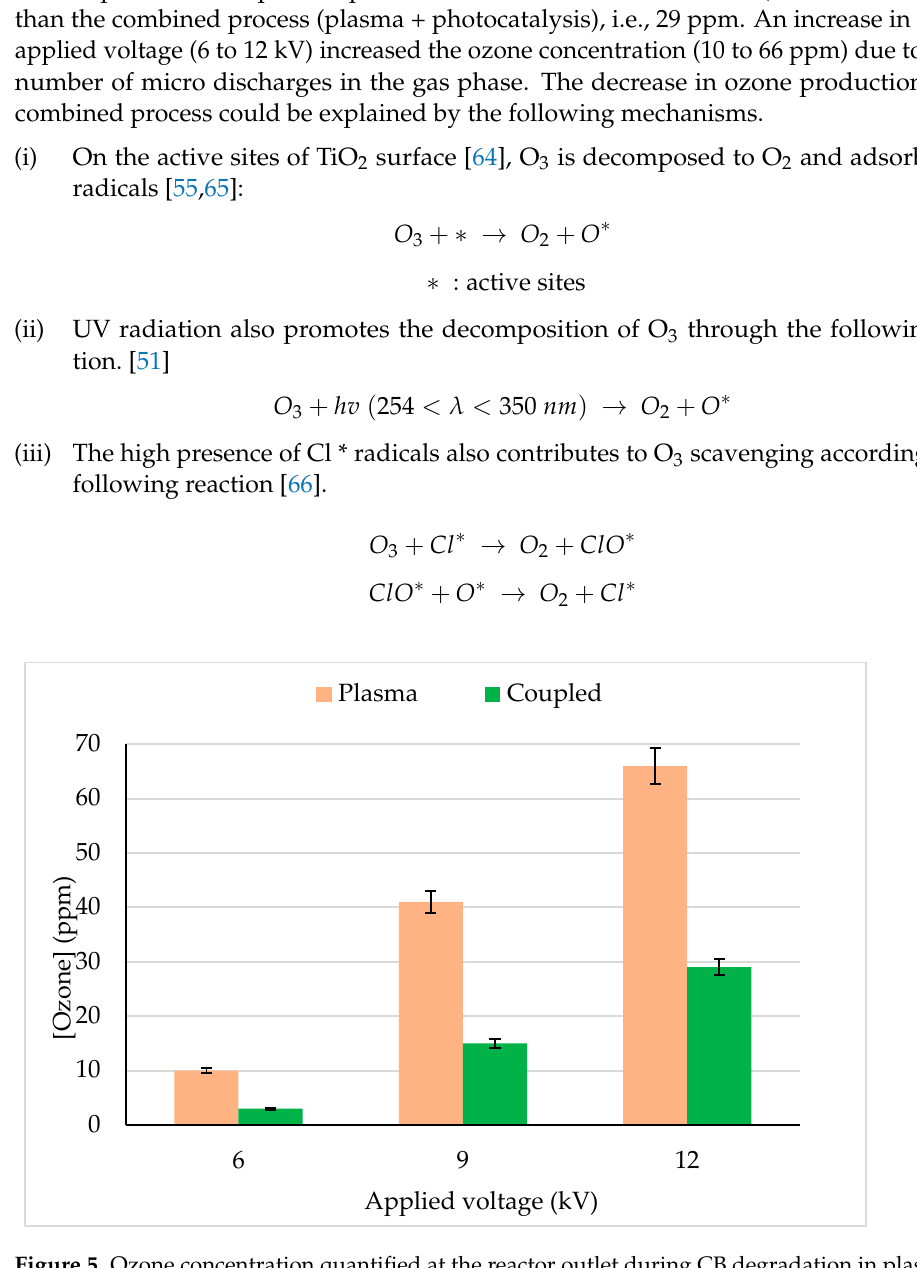
Figure 5. Ozone concentration quantified at the reactor outlet during CB degradation in plasma and the coupling process. CB inlet concentration: 13 mg/m 3 , Flow rate: 0.25 m 3 /h, RH: 5%, Temperature: 20 °C, Plasma applied frequency: 50 Hz.